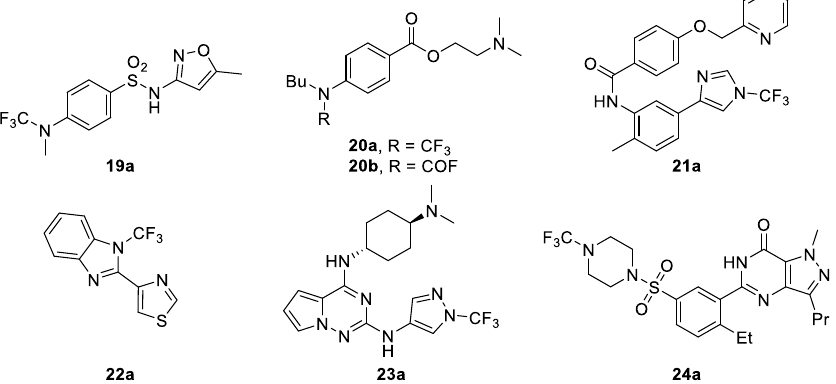
Figure 3. Synthesis of N -trifluoromethyl compounds to determine their aqueous stability and additional key in vitro properties. Table 1. Half-life of N -CF 3 compounds 19a – 24a [a] .